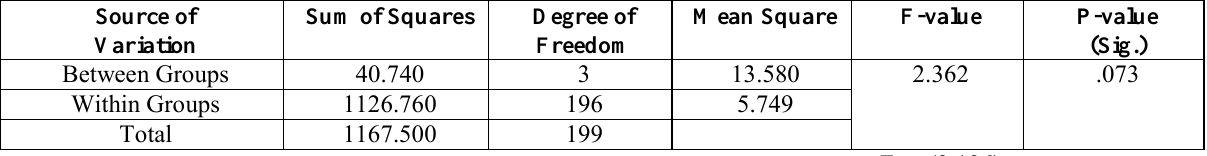
Analysis of Variance (ANOVA) results among North, East, West and South regions female baseball players with